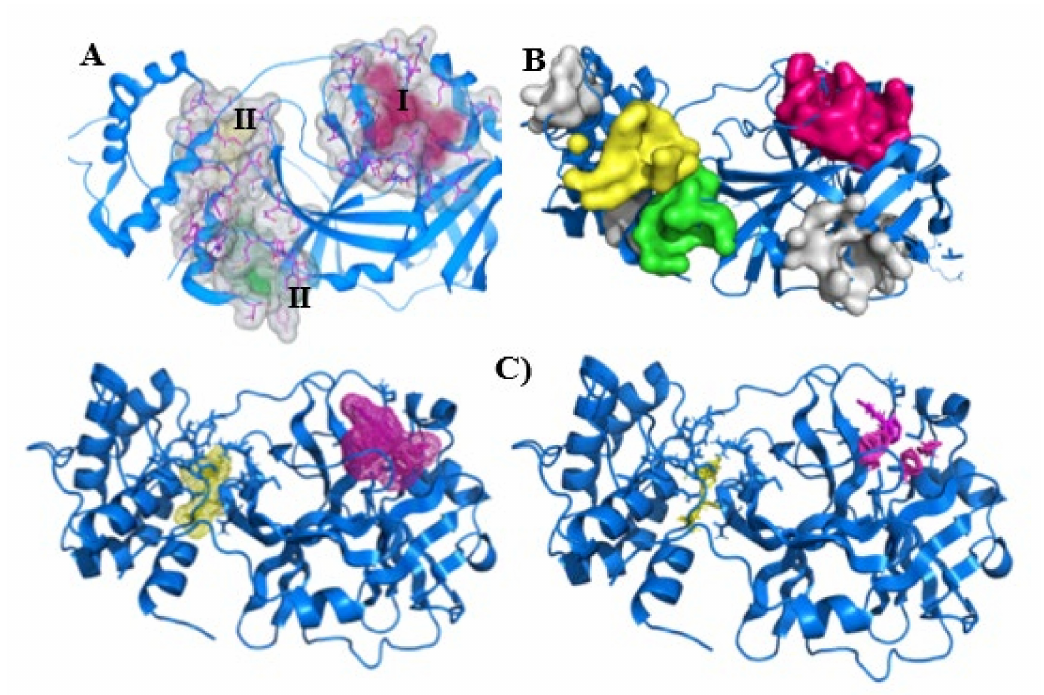
Figure 2. Three-dimensional structure of the SARS-CoV-2 main protease (SARS-CoV-2 Mpro, PDB ID: 5R82, blue cartoon). ( A ) Binding sites (surface and pink sticks) found by SeeSAR version 9.2 (BioSolveIT GmbH) in the active site (I) are colored in pink (25 residues), at site II (19 residues) in yellow, and at site III (15 residues) in green. This image was generated by the SeeSAR program. ( B ) Main pockets (color surfaces) predicted by PockDrug server [47]. The active site (I) is colored in pink (volume = 1892 Å 3 , druggability score = 0.63 ± 0.09), at site II (volume = 643 Å 3 , druggability score = 0.35 ± 0.08) in yellow, and at site III (volume = 760 Å 3 , druggability score = 0.33 ± 0.03) in green. The remaining gray sites presented a druggability score of 0.55 ± 0.10 (upper), 0.98 ± 0.01 (middle), and 0.61 ± 0.04 (lower). ( C ) Main hot spots (mesh and sticks) calculated by FTMap server [49]. The active site is colored in pink and was classified as druggable ( ≥ 16 probes) [54], the second site (yellow) is borderline (13 ≤ probes < 16), and pink and yellow sticks show the location of the probe. The B and C images were generated by educational Pymol 2.4.1